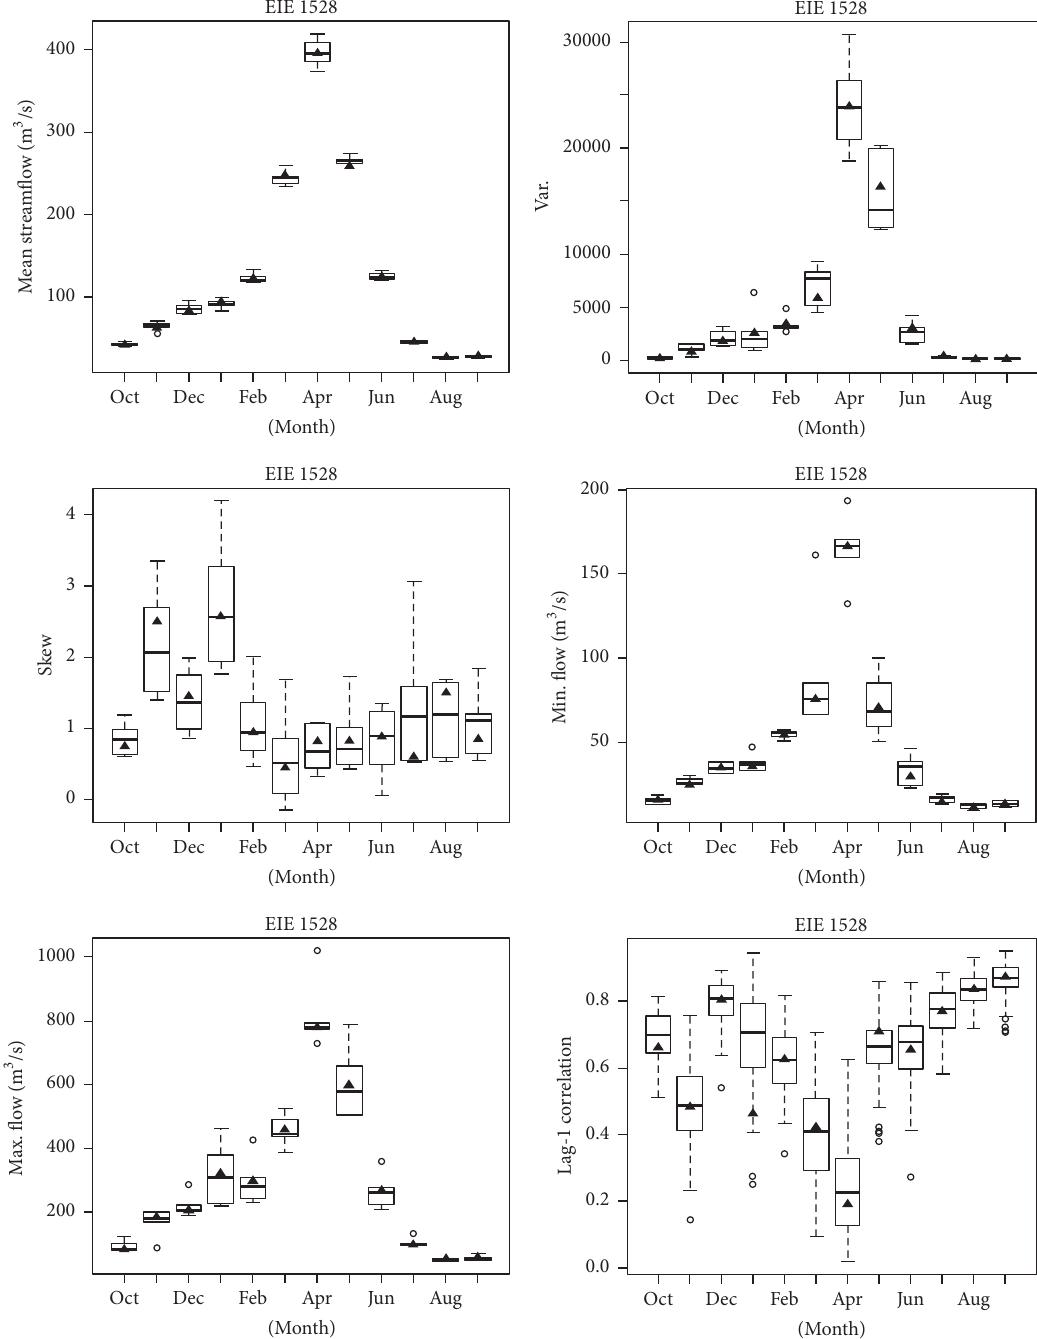
Figure 5: Simulated and observed statistics values from EIE1528 station. The triangle denotes the observed values.